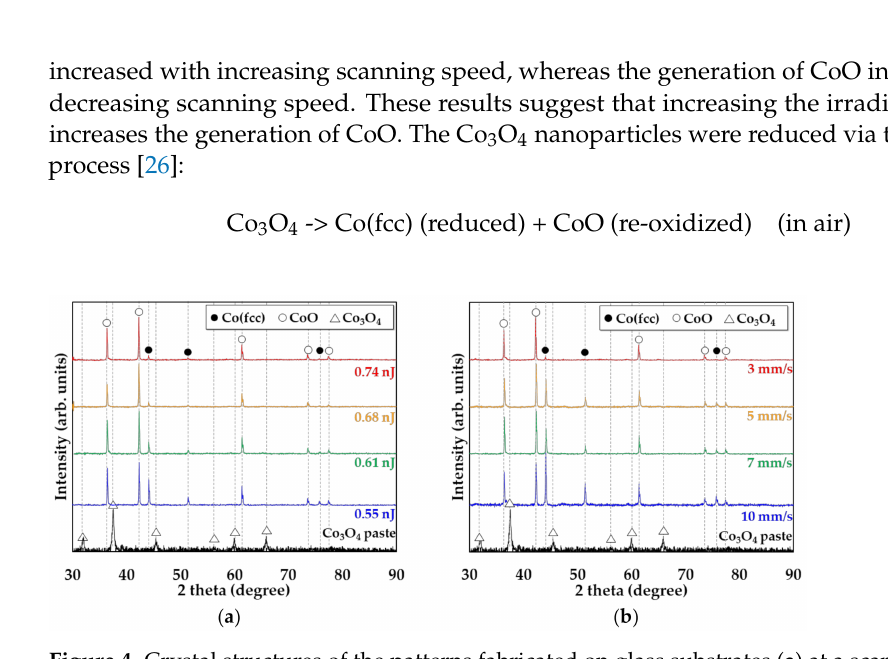
Figure 4. Crystal structures of the patterns fabricated on glass substrates ( a ) at a scanning speed of 5 mm/s and a pulse energy of 0.55–0.74 nJ, and ( b ) a scanning speed in the range 3–10 mm/s with a pulse energy of 0.55